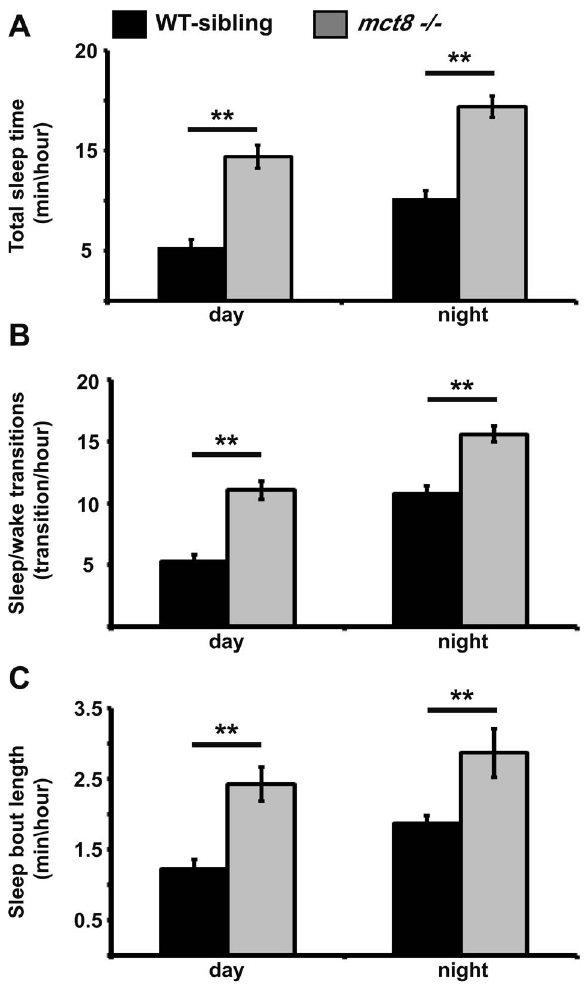
Figure 5. Sleep architecture of mct8 2 / 2 larvae. A–C . Recording of sleep was performed in 6 dpf mct8 2 / 2 and WT-sibling larvae during 24 h under a 14 h light/10 h dark cycle. Total sleep time ( A ), the number of sleep/wake transitions ( B ) and sleep-bout length ( C ) monitored in mct8 2 / 2 and WT-sibling larvae. Values are represented as means 6 SEM (standard error of the mean). Statistical significance was determined by t -test: two-sample assuming unequal variances (** p , 0.001